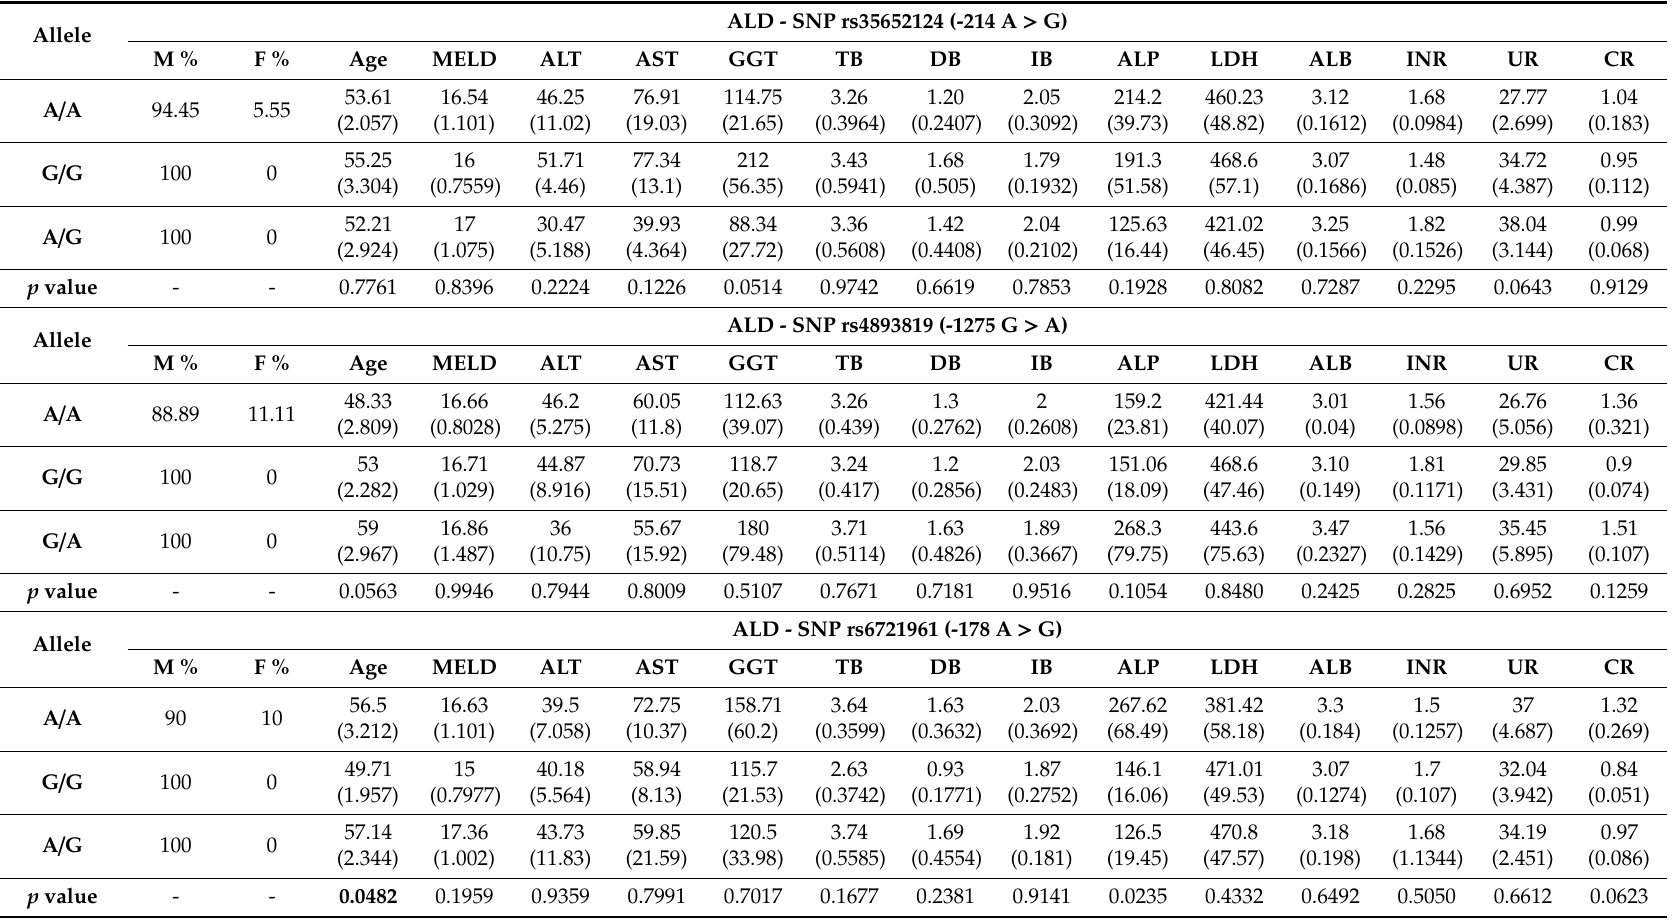
Table 6. Allele frequencies compared clinical data to Alcoholic liver disease (ALD)